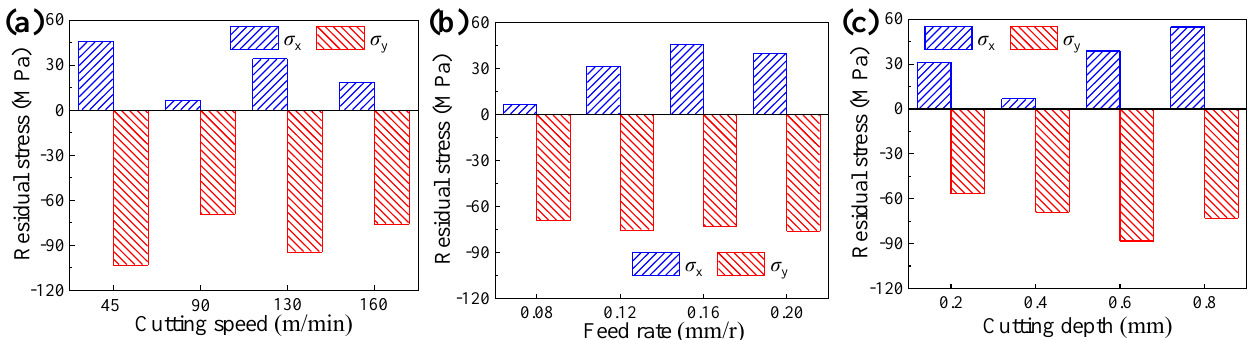
Figure 10. Surface residual stresses of samples obtained under different cutting parameters: ( a ) cutting speed, ( b ) feed rate, and ( c ) cutting depth.